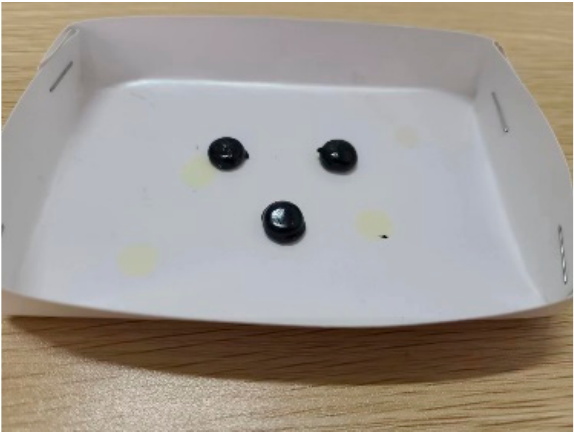
Figure 6. The 8 mm-bitumen specimens used in the LAS and LASH tests.